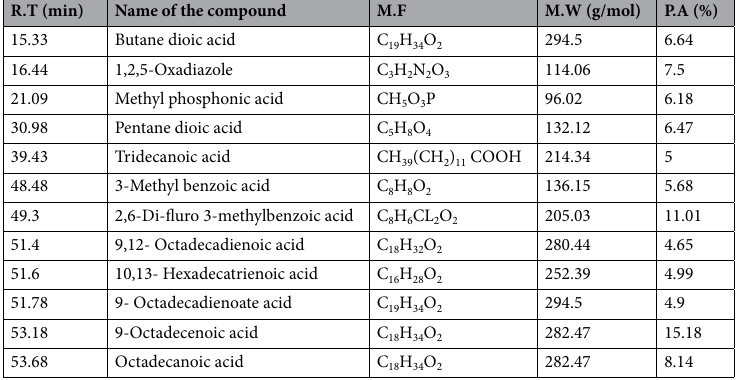
Table 12. Relative percentage of fatty acids in